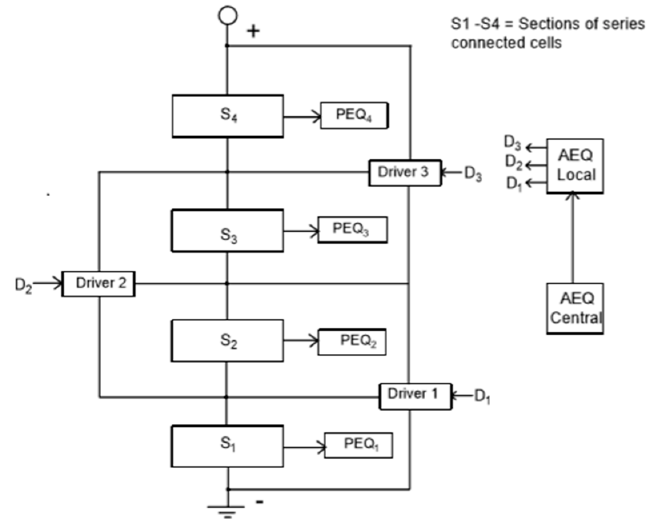
Figure 1. BEQ connections to a battery with 4 sections.